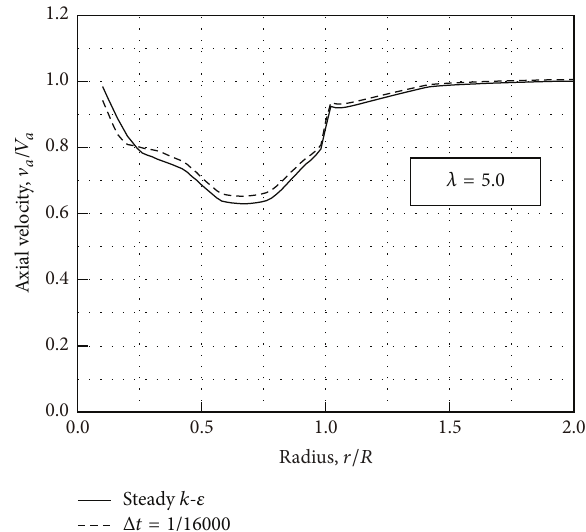
Figure 9: Local thrust coefficient for tip speed ratio 𝜆 = 5 .